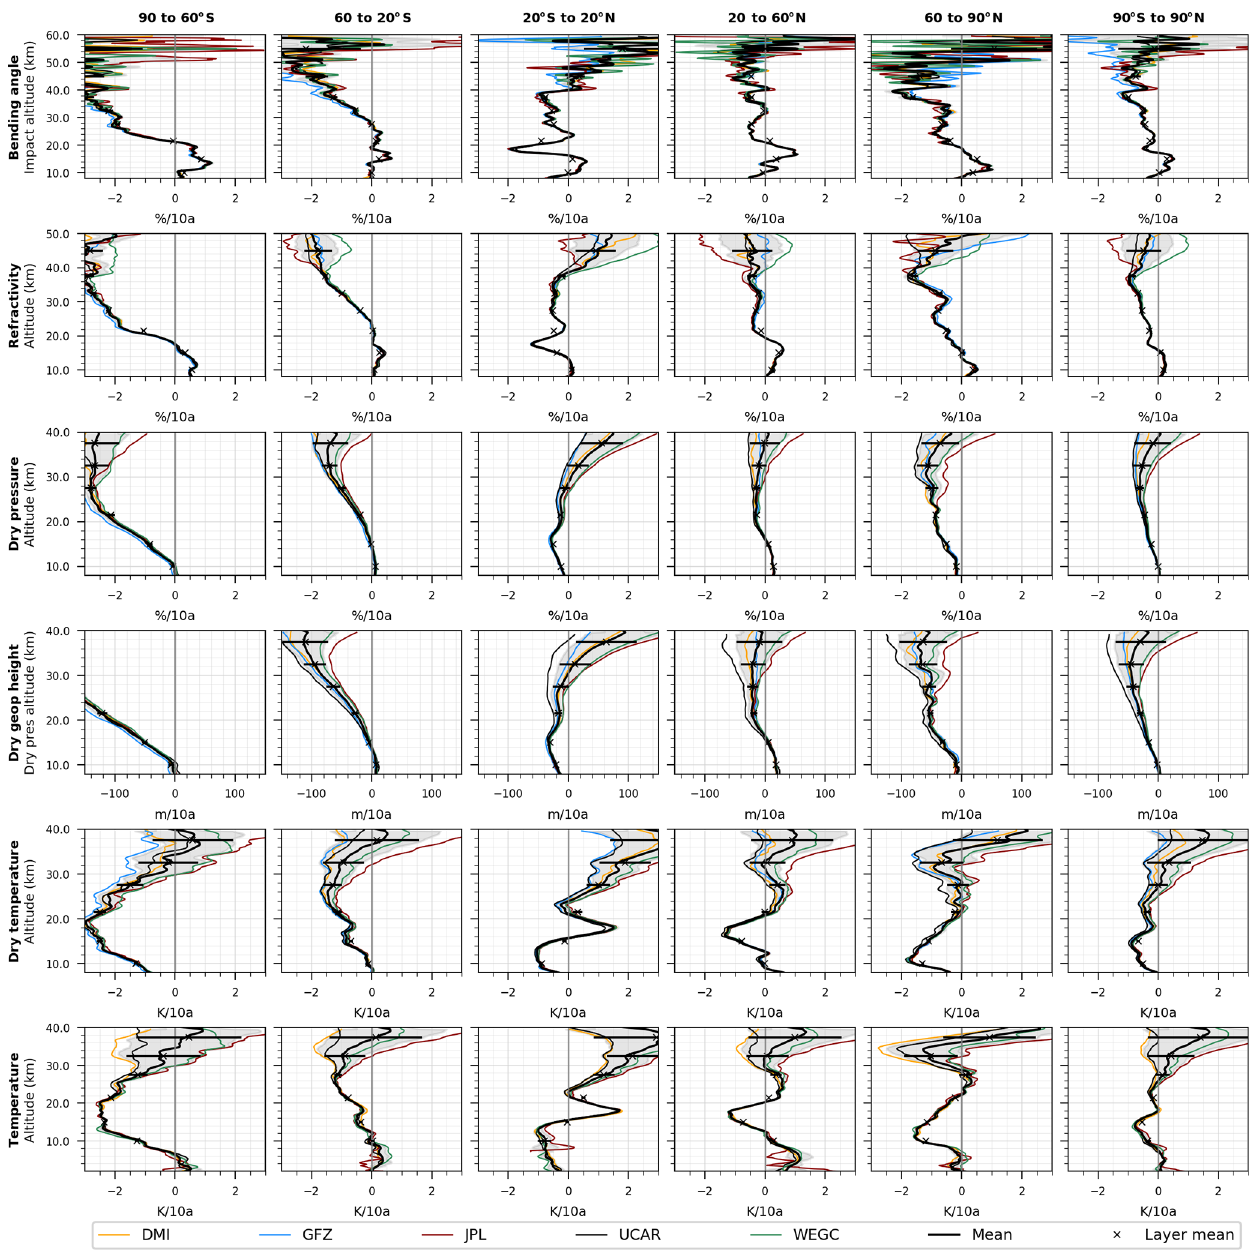
Figure 8. CHAMP structural uncertainty indicated as the standard deviation (gray) of the individual center trends per decade based on 10 ◦ zonal medians for DMI (orange), GFZ (blue), JPL (red), UCAR (black), and WEGC (green); shown for bending angle, refractivity, dry pressure, dry geopotential height, dry temperature, and temperature (top to bottom). The all-center mean trend profile (bold black line) and the altitude-layer mean trends (crosses, with horizontal bars showing the uncertainty) are indicated. Profiles are smoothed with a 1km running